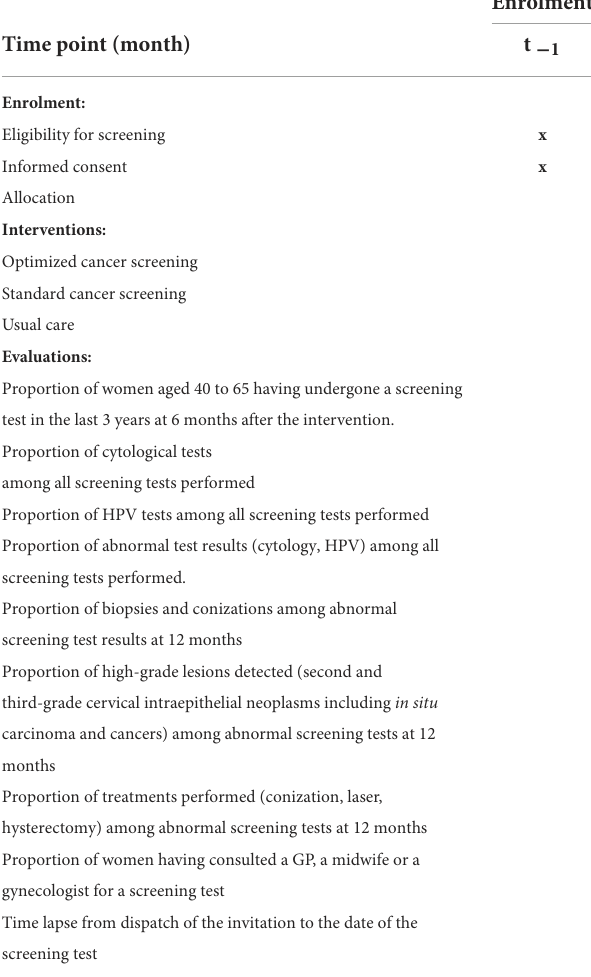
Study period Enrolment Allocation